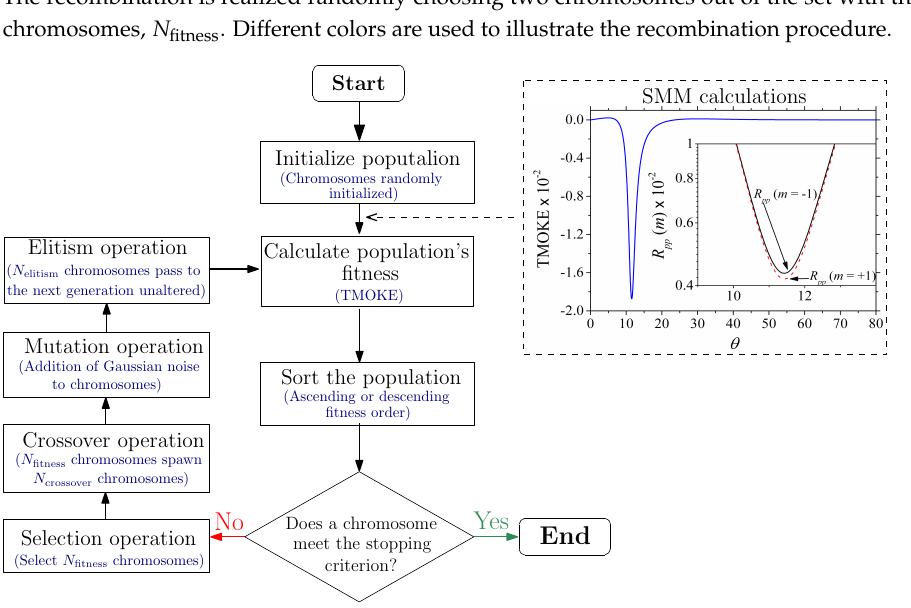
Figure 4. The flow chart of the GA used for the design of ε -near-zero magnetophotonic nanostructures with optimized TMOKE values. The dashed rectangle at the top right side shows the calculation of TMOKE and reflectances R p ( m = ± 1 ) (in the inset), using the SMM algorithm, for a randomly generated population of chromosomes in the first step on the left side. This last procedure is illustrated using an initially selected arbitrary